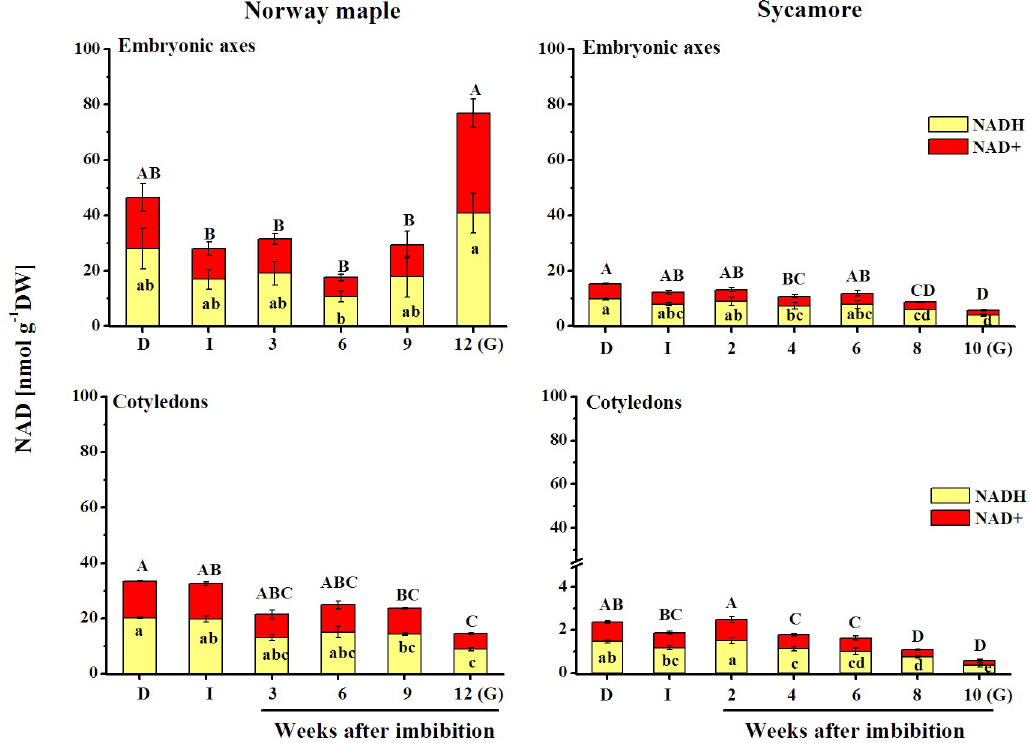
Fig 1. Levels of reduced (NADH) and oxidized (NAD + ) forms of nicotinamide adenine dinucleotide (NAD) detected in dry and germinating Norway maple and sycamore seeds. (D) Dry seeds; (I) Imbibed seeds; (G) Germinated seeds. Data represent the mean ± standard deviation of three independent replicates. Statistically significant differences are indicated with different letters (one-way ANOVA followed by Tukey’s test at p � 0.05). The capital letters refer to the oxidized form.